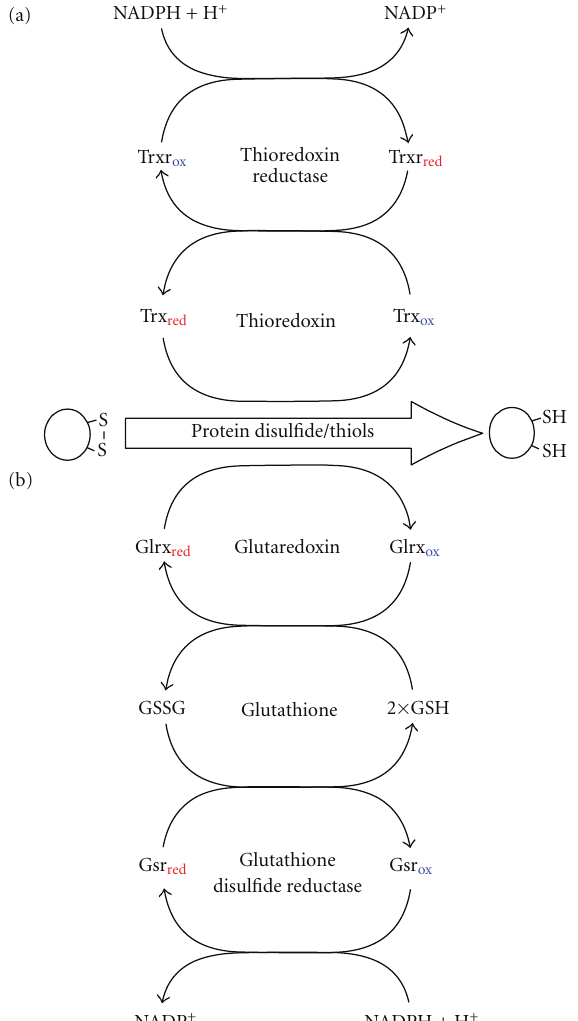
Figure 4: Glutathione-glutaredoxin and thioredoxin redox regula- tion systems. (a) Thioredoxin receives electrons from thioredoxin reductase and uses these to directly reduce protein disulfides. (b) Glutathione receives electrons from glutathione disulfide reductase; however, reduction of protein disulfides by glutathione is mediated through glutaredoxin. These two systems have similar functions, although there is evidence that indicates they each interact with di ff erent subsets of proteins. Arrows represent a change in redox state (loss or gain of